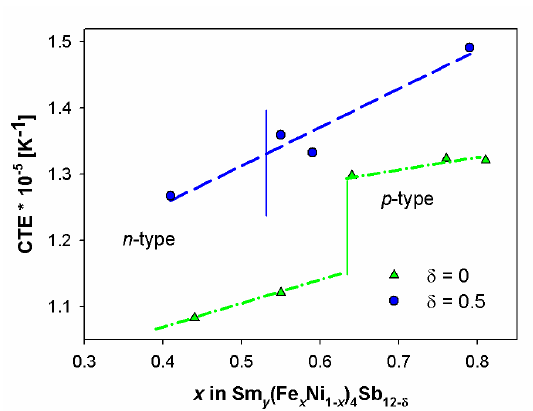
Figure 10. Trend of CTE as a function of x for the Sm y (Fe x Ni 1 − x ) 4 Sb 11.5 Sn 0.5 and Sm y (Fe x Ni 1 − x ) 4 Sb 12 systems. The dashed blue line is a regression line, while the dash-dot green lines are guides for the eye. Vertical lines separate n - from p -compositions for both systems; their position relies on structural data. Error bars are hidden by data markers; the data of the Sm y (Fe x Ni 1 − x ) 4 Sb 12 system are taken from ref. [61].